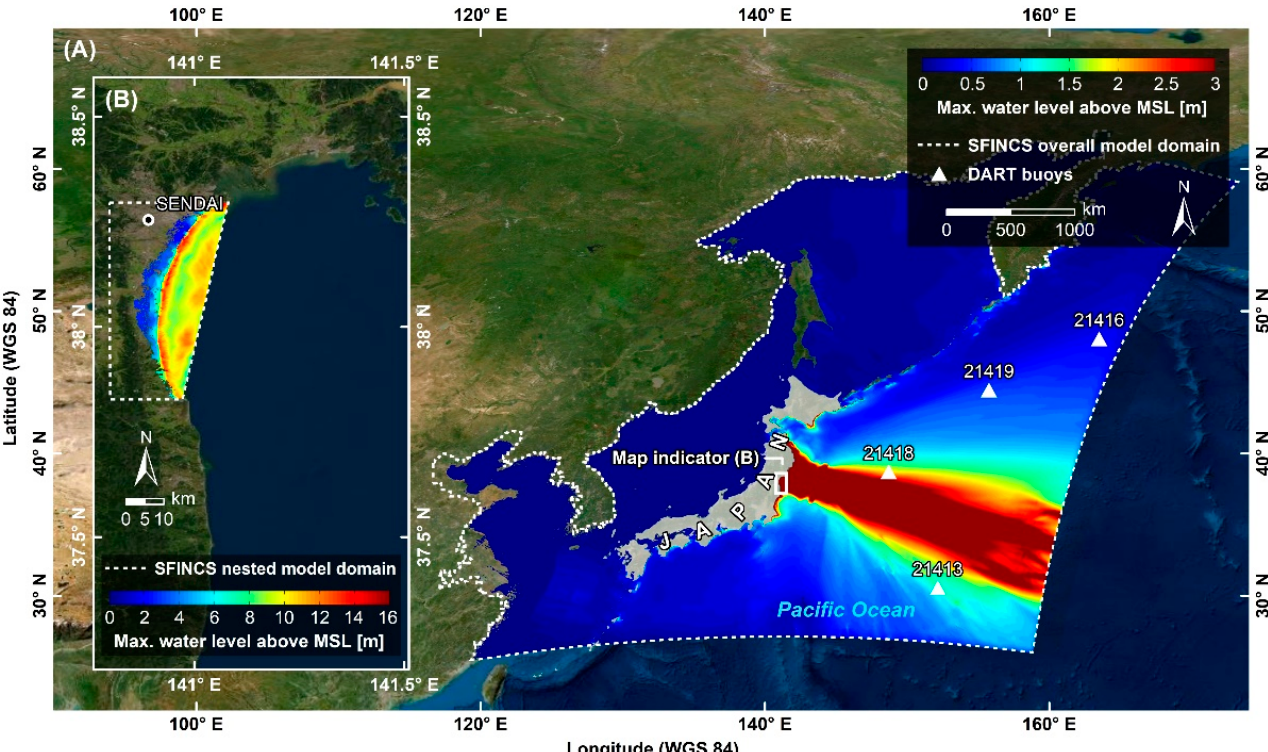
Figure 4. Maximum water levels above mean sea level (MSL) simulated for the 2011 T ō hoku tsunami with the overall SFINCS model for the Northwestern Pacific Ocean ( A ) and with the nested SFINCS model for Sendai Bay ( B ).